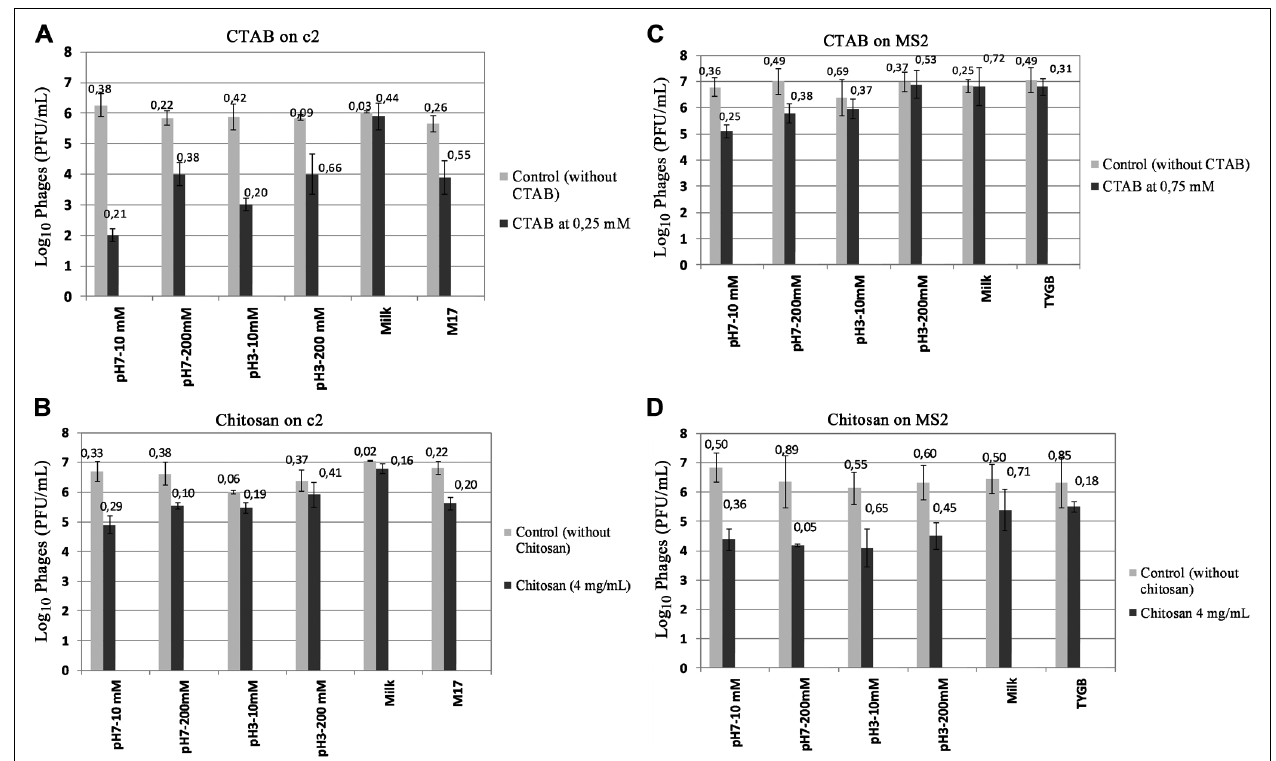
FIGURE 2 | Effect of matrices on antiviral activity: (A)Antiviral activity of CTAB on c2 in different matrices. (B) Antiviral activity of Chitosan on c2 in different matrices. (C) Antiviral activity of CTAB on MS2 in different matrices.